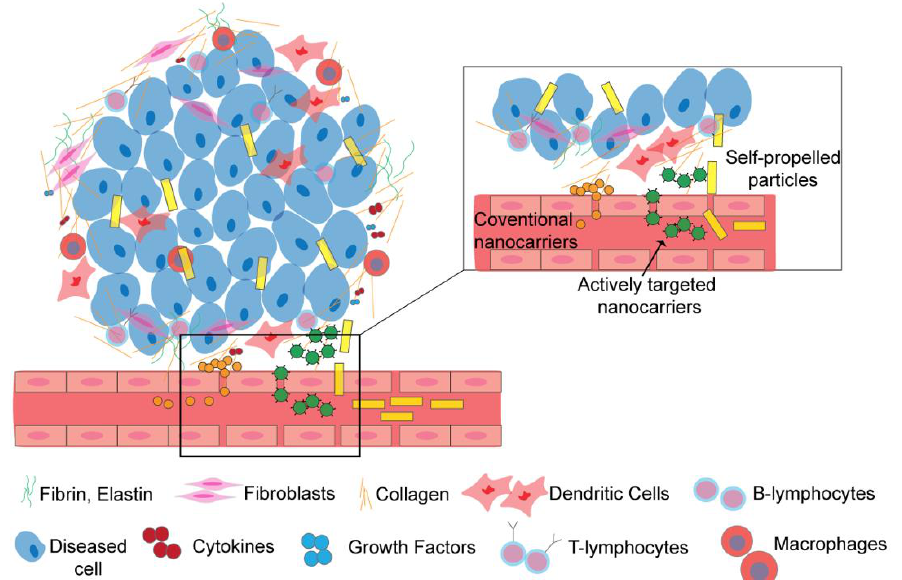
Figure 1. Vision of using self-propelled particles in ECM environments. The figure shows a sche- matic of the extracellular matrix surrounding a solid tumor and the movement of different types of drug delivery nanocarriers within it. Conventional nanocarriers with no active targeting moieties are stuck at the periphery of the dense microenvironment surrounding cells. Active nanocarriers (which are not able to propel themselves but are decorated with targeting moieties) move further into the ECM (inset) compared to passive nanocarriers but the ECM still acts as a barrier to them. Self-propelled particles (SPPs) can propel further in the ECM and deliver their cargo (e.g., drugs) closest to the diseased cells; as a result, SPPs are dispersed throughout the tumor microenvironment, dramatically improving the distribution of the therapeutic cargo within the tumor compared to pas- sive nanocarriers.